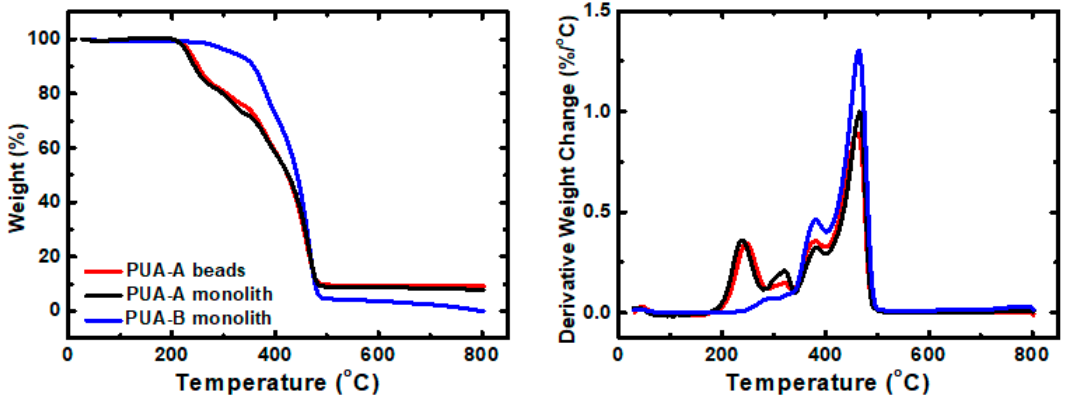
Figure 8. Weight loss as a function of temperature ( left ) and derivative weight loss with temperature ( right ) of spherical PUA aerogel beads and PUA monoliths synthesized in propylene carbonate using the same monomer concentration, as indicated. Table 2. Thermal decomposition of PUA spherical aerogel beads and monoliths.